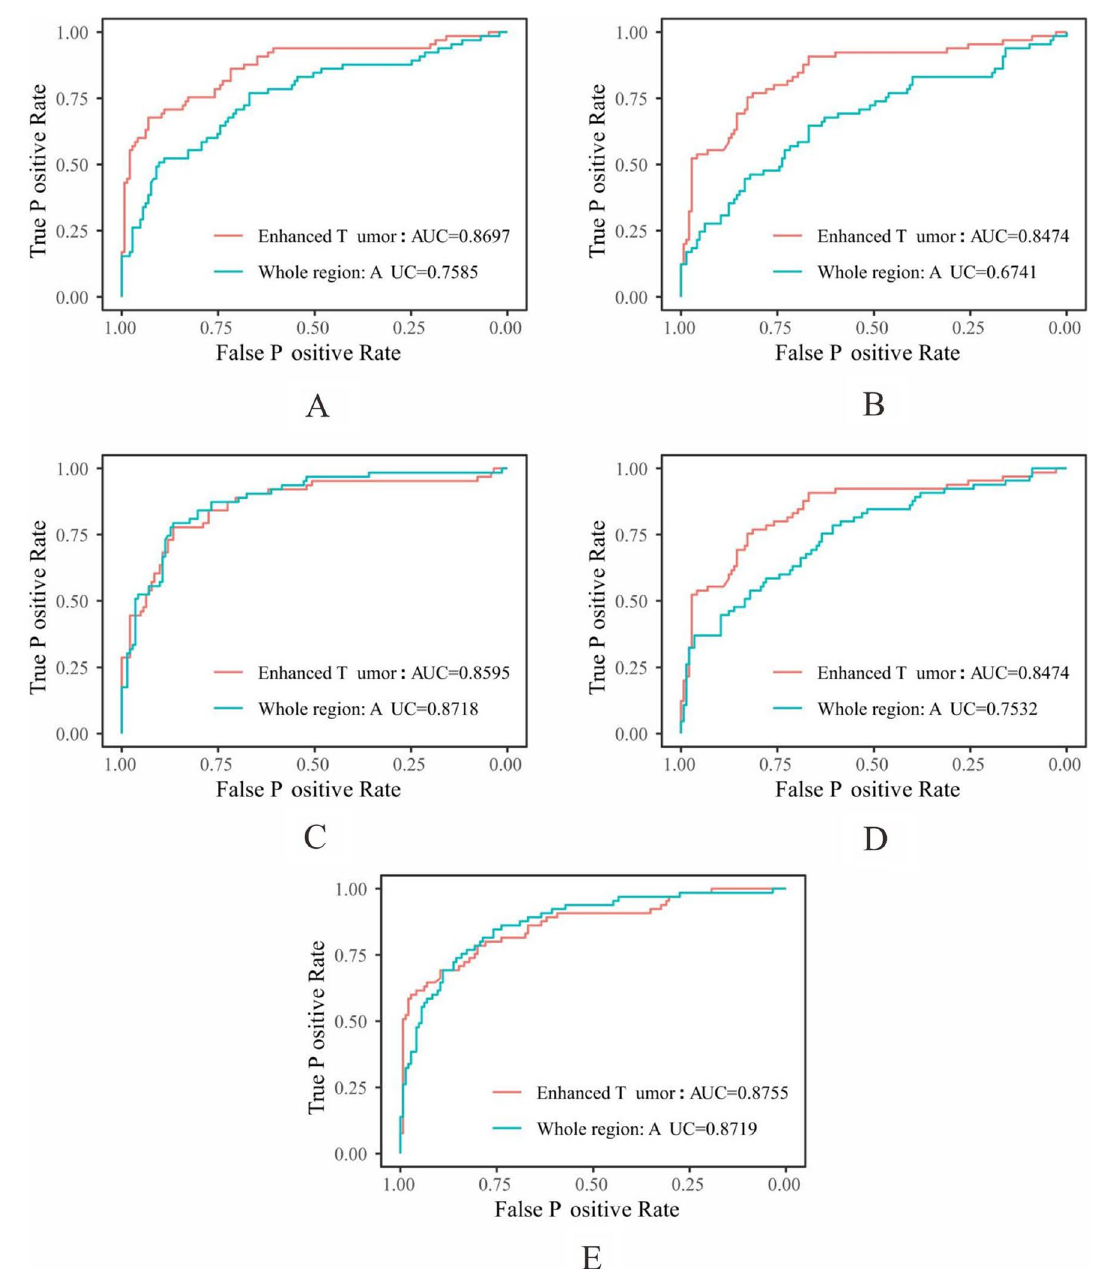
Fig. 5 ROC curves derived from the ET subregion and the whole tumor in four MRI sequences. a FLAIR. b T1. c T1Gd. d T2. e Multiparamet- ric